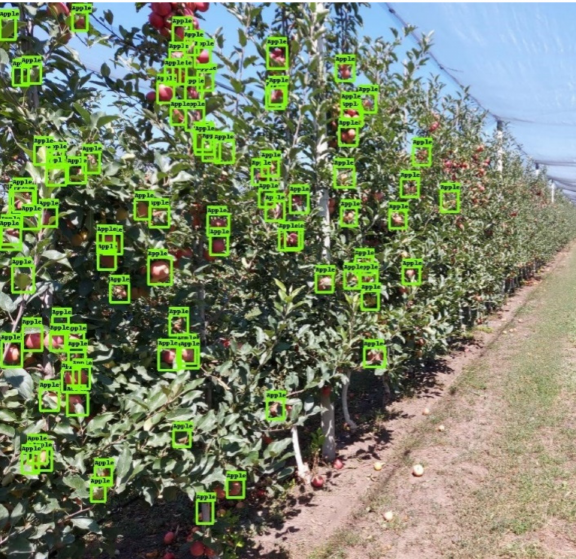
Figure 4. Automated apple fruit counting on images for crop load estimation in an industrial orchard (Solovchenko et al.,